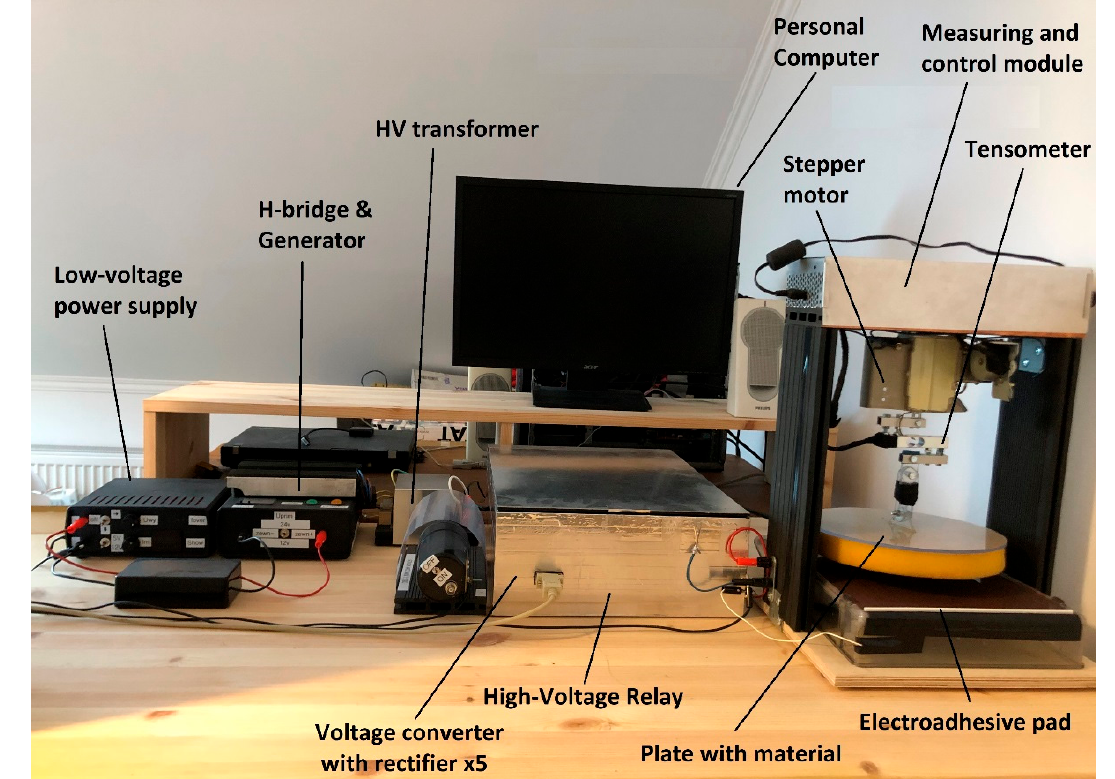
Figure 4. The actual measurement system.